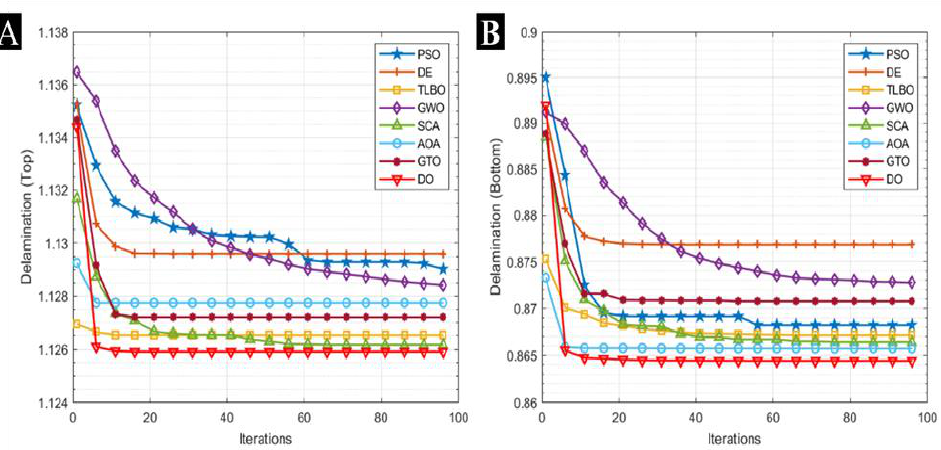
Figure 9. Convergence curves of different nature-inspired algorithms when optimizing the delamination sizes at the: ( A ) top and ( B ) bottom sides. Table 6. Wilcoxon signed-rank test for the pairwise comparison between DO and other nature- inspired algorithms when optimizing the delamination size at the top side. DO vs.